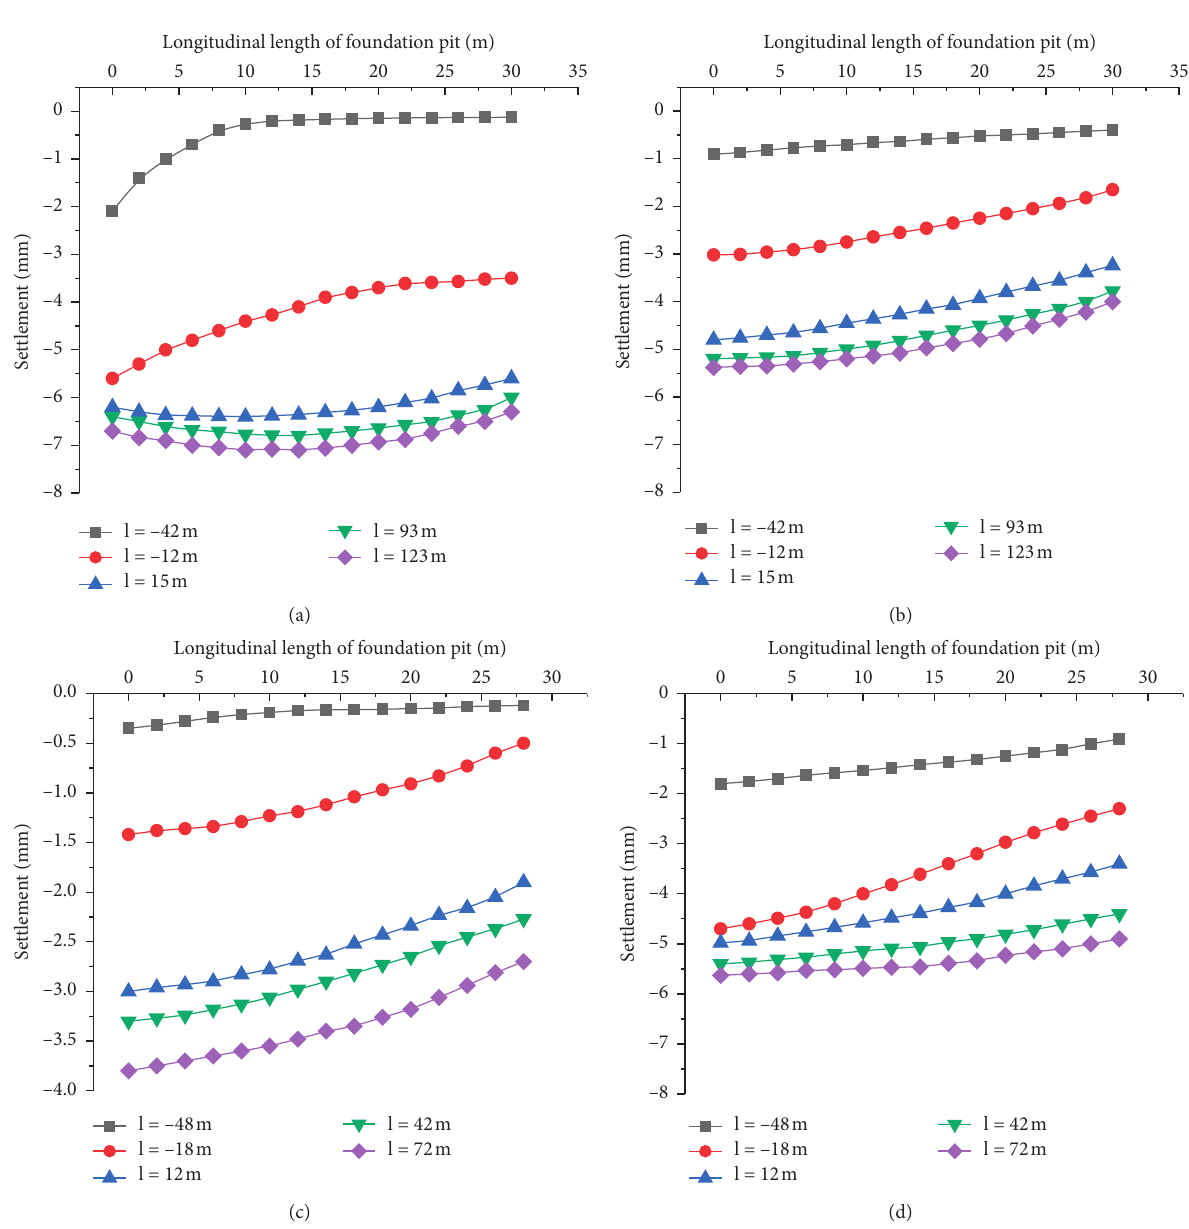
Figure 7: Relationship between face distance and longitudinal settlement. (a) No.1 foundation pit near tunnel side. (b) No.1 foundation pit far tunnel side. (c) No. 2 foundation pit near tunnel side. (d) No. 2 foundation pit far tunnel